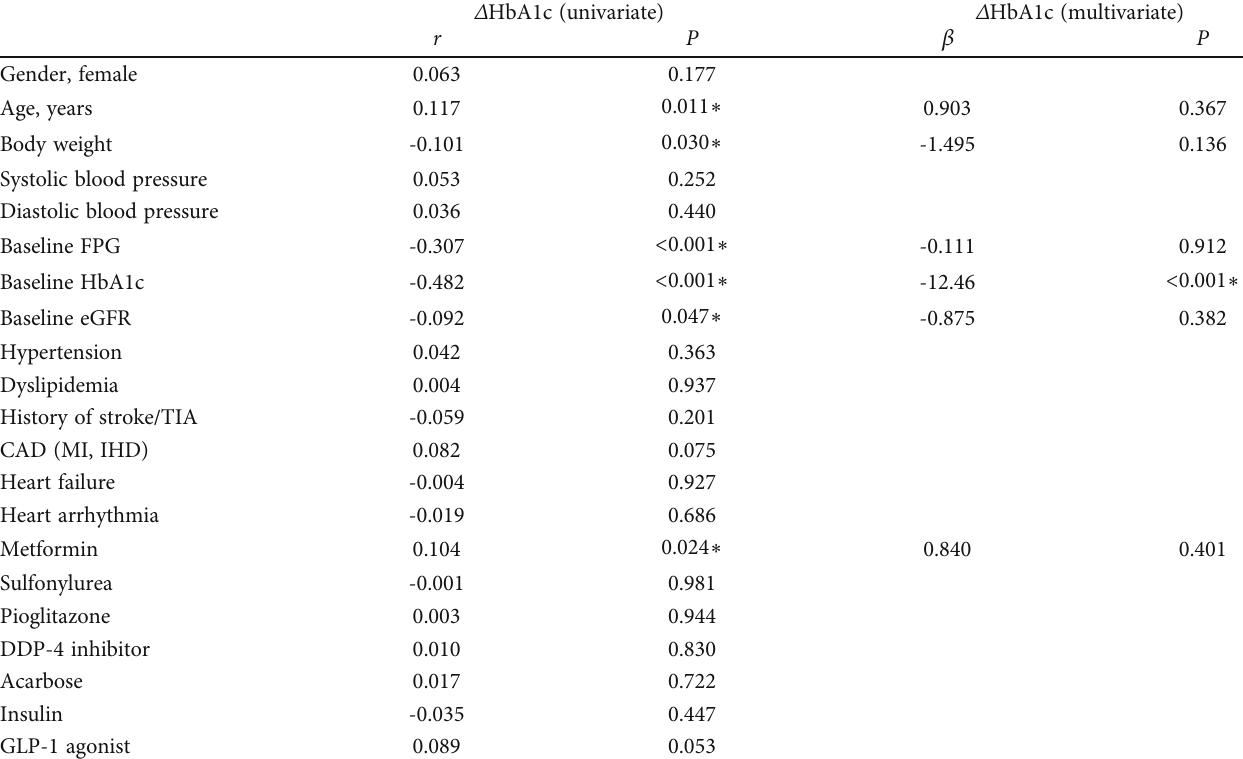
CAD: coronary artery disease; DDP-4: dipeptidyl peptidase-4; eGFR: estimated glomerular fi ltration rate; FPG: fasting plasma glucose; GLP-1: glucagon-like peptide-1; HbA1c: hemoglobin A1c; IHD: ischemic heart disease; MI: myocardial infarction; TIA: transient ischemic attack. ∗ p value < 0.05 were considered statistically signi fi cant ( ∗ upper